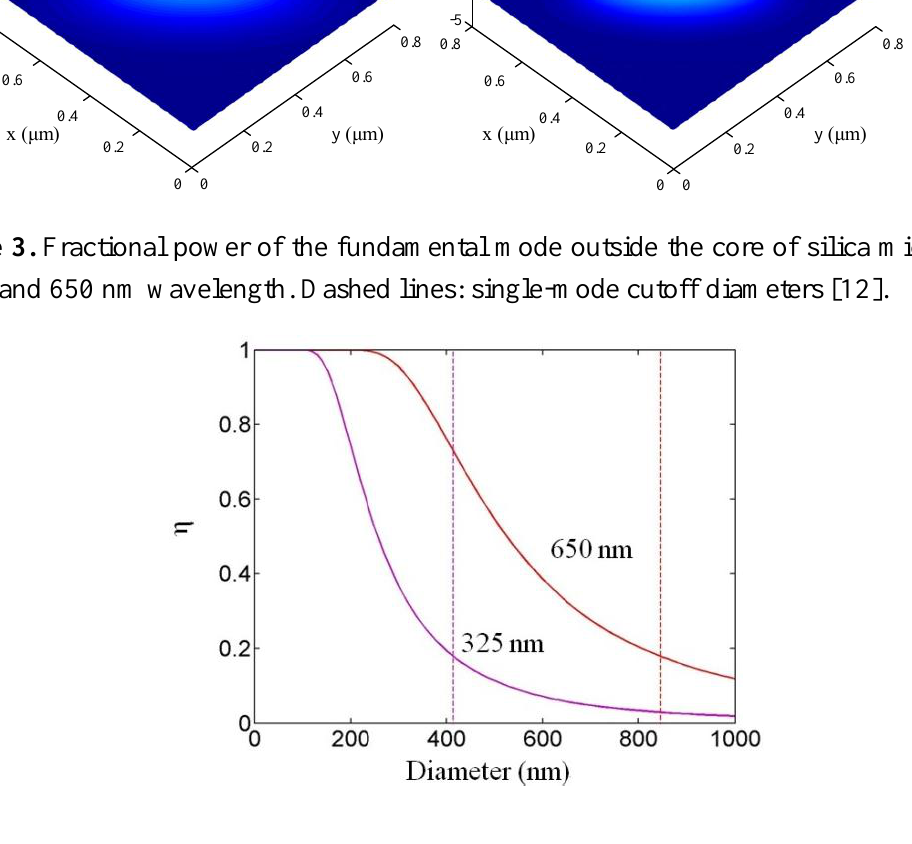
) of the HE mode of a ( a ) 200 and ( b ) z 11